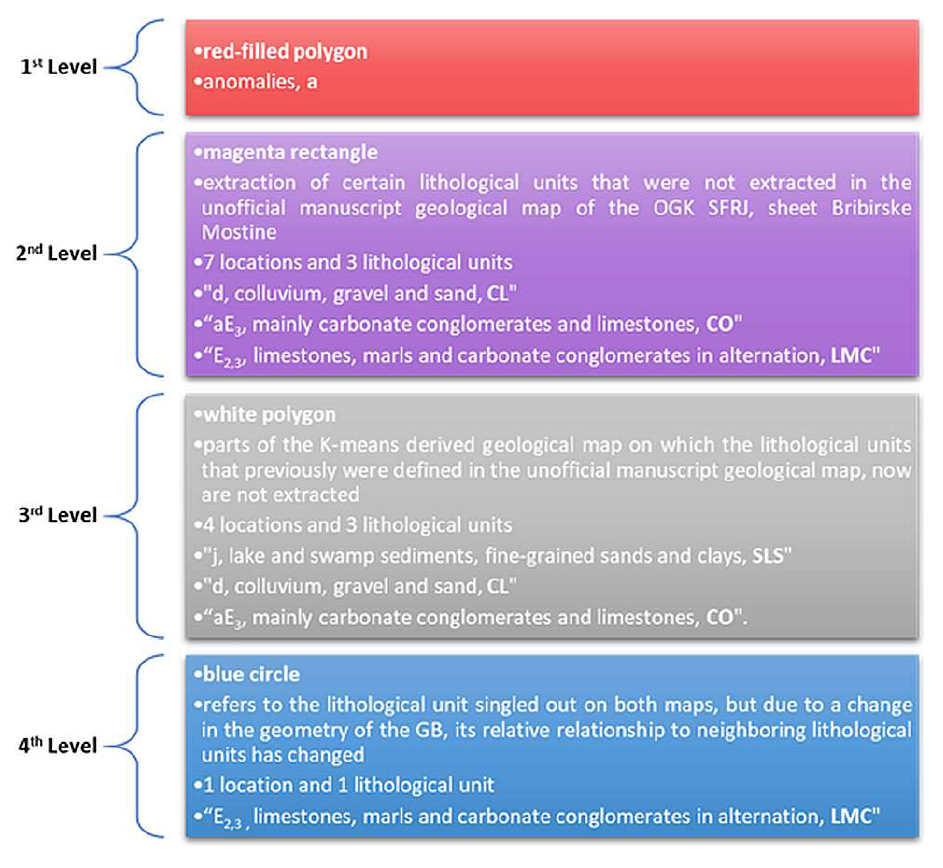
Figure 10. Four derived LODs.